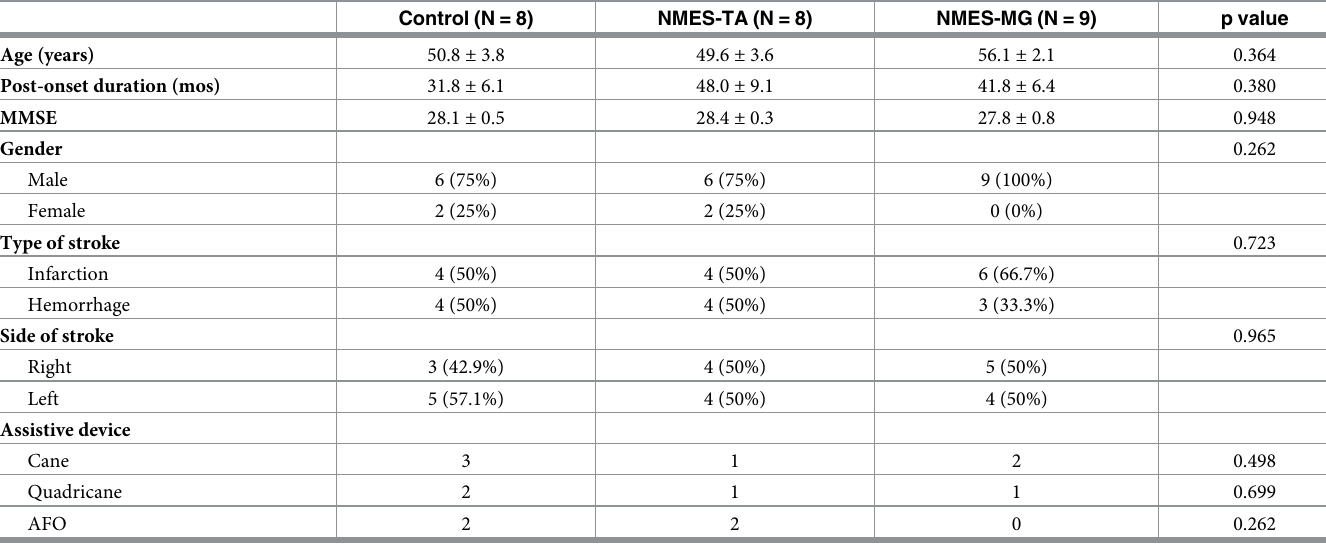
Table 1. Demographic characteristics of the participants.